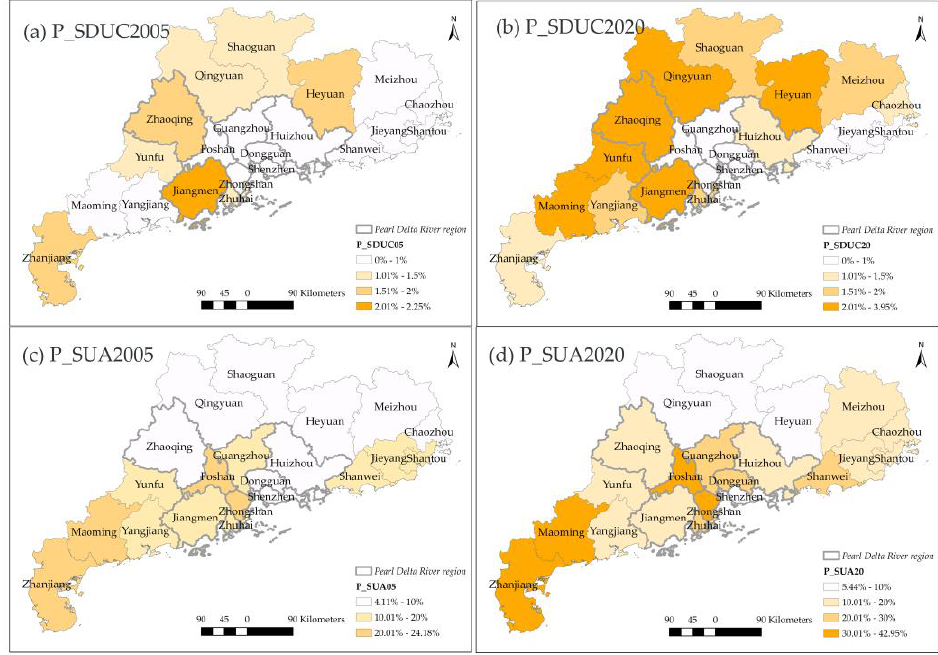
Figure 7. The spatial distribution of P_SDUC and P_SUA in 2005 and 2020.